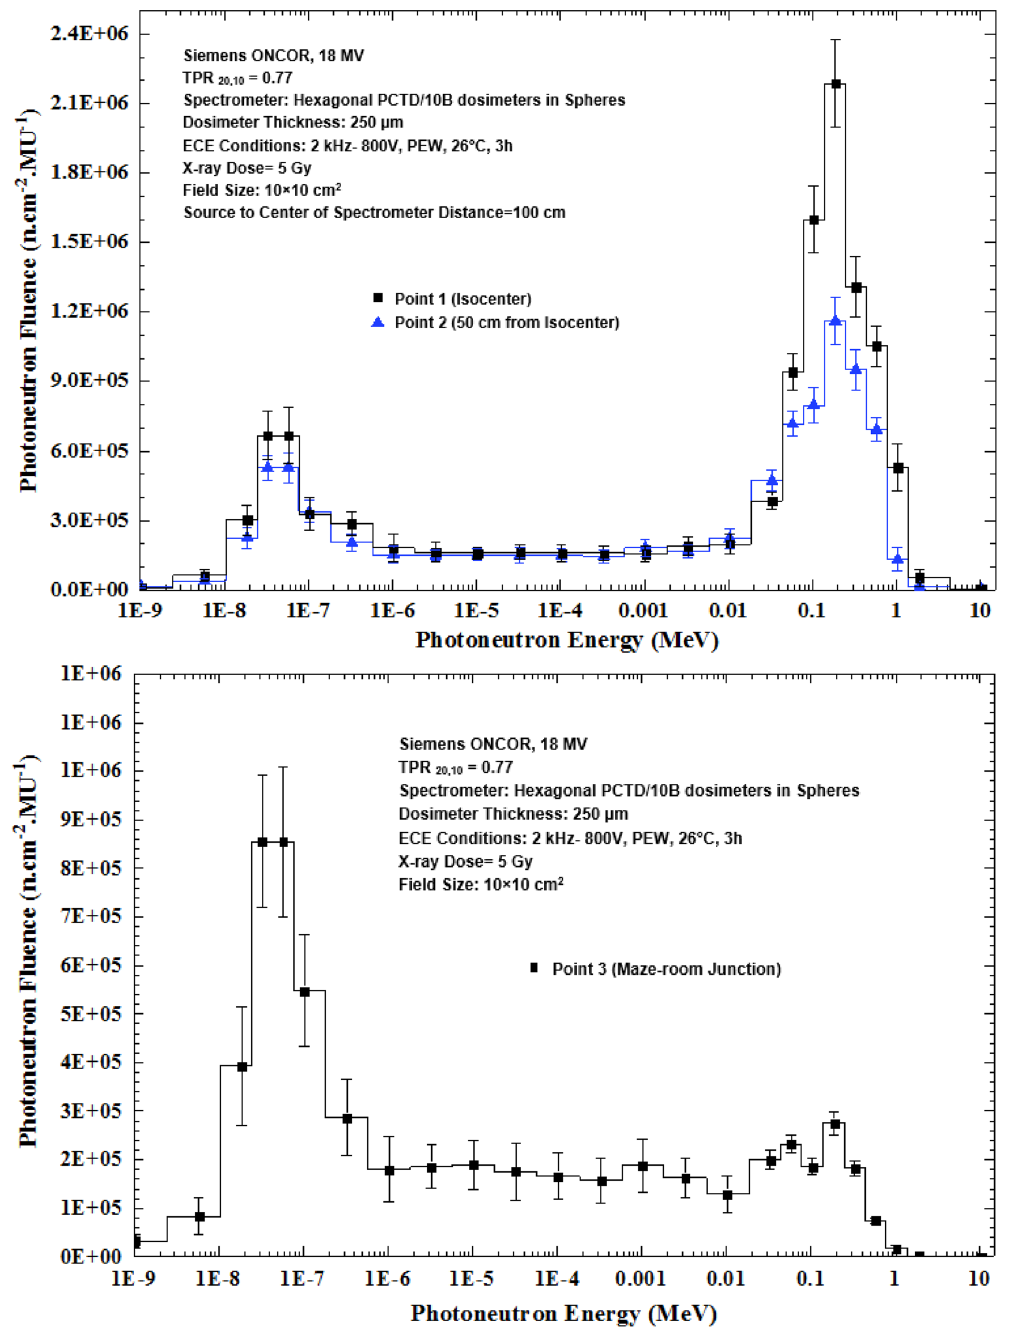
Figure 9. The PN spectra determined at 3 locations in the accelerator bunker; the isocenter, 50 cm from the isocenter, and at the maze-room junction in a 10 × 10 cm 2 field for 5 Gy 18 MV X-rays